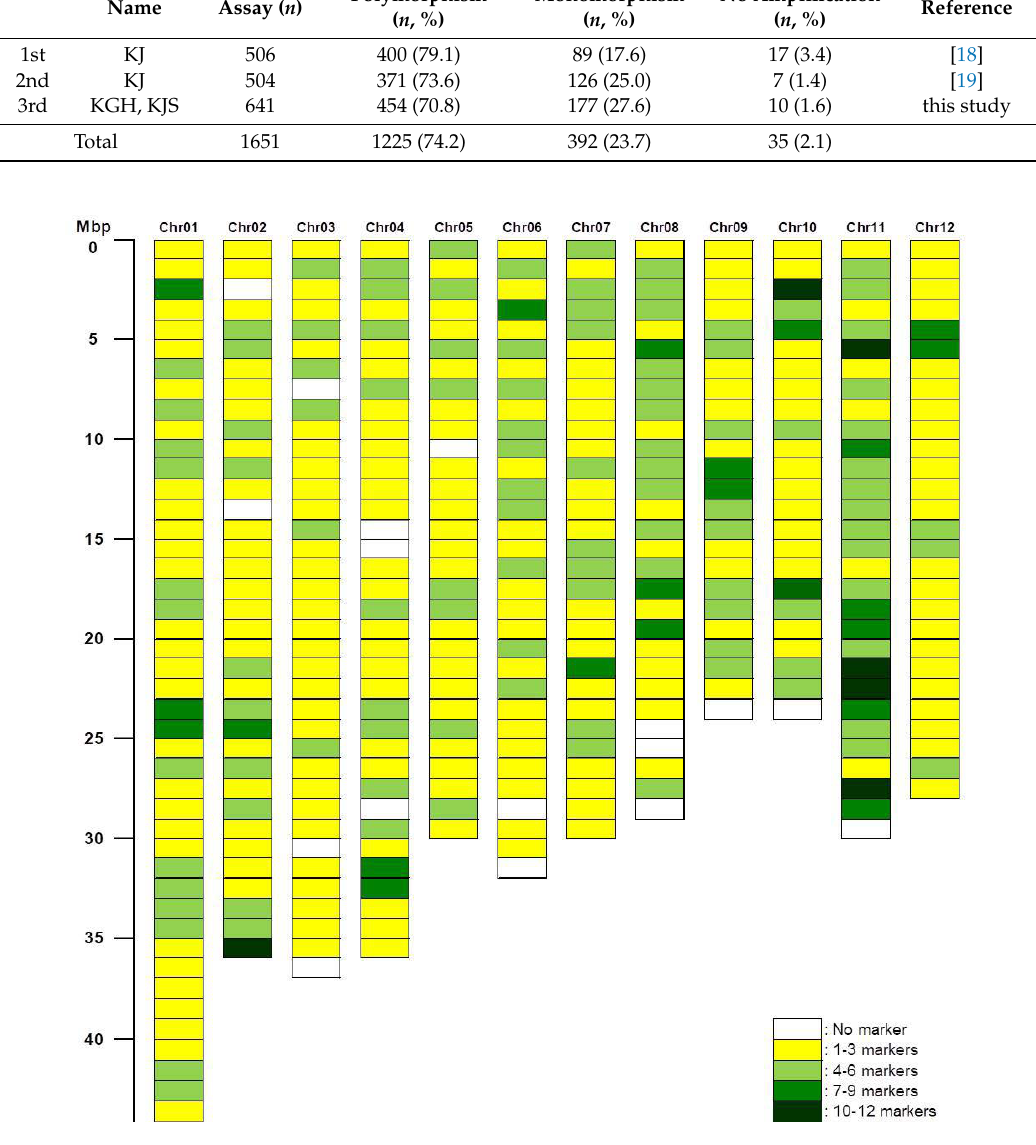
Figure 3. Distribution of 1225 polymorphic KASP markers developed with Korean temperate japonica rice varieties. Columns represent chromosomes, and rows represent physical position (1 Mbp intervals). Cell colors indicate the numbers of polymorphic KASP markers per Mbp